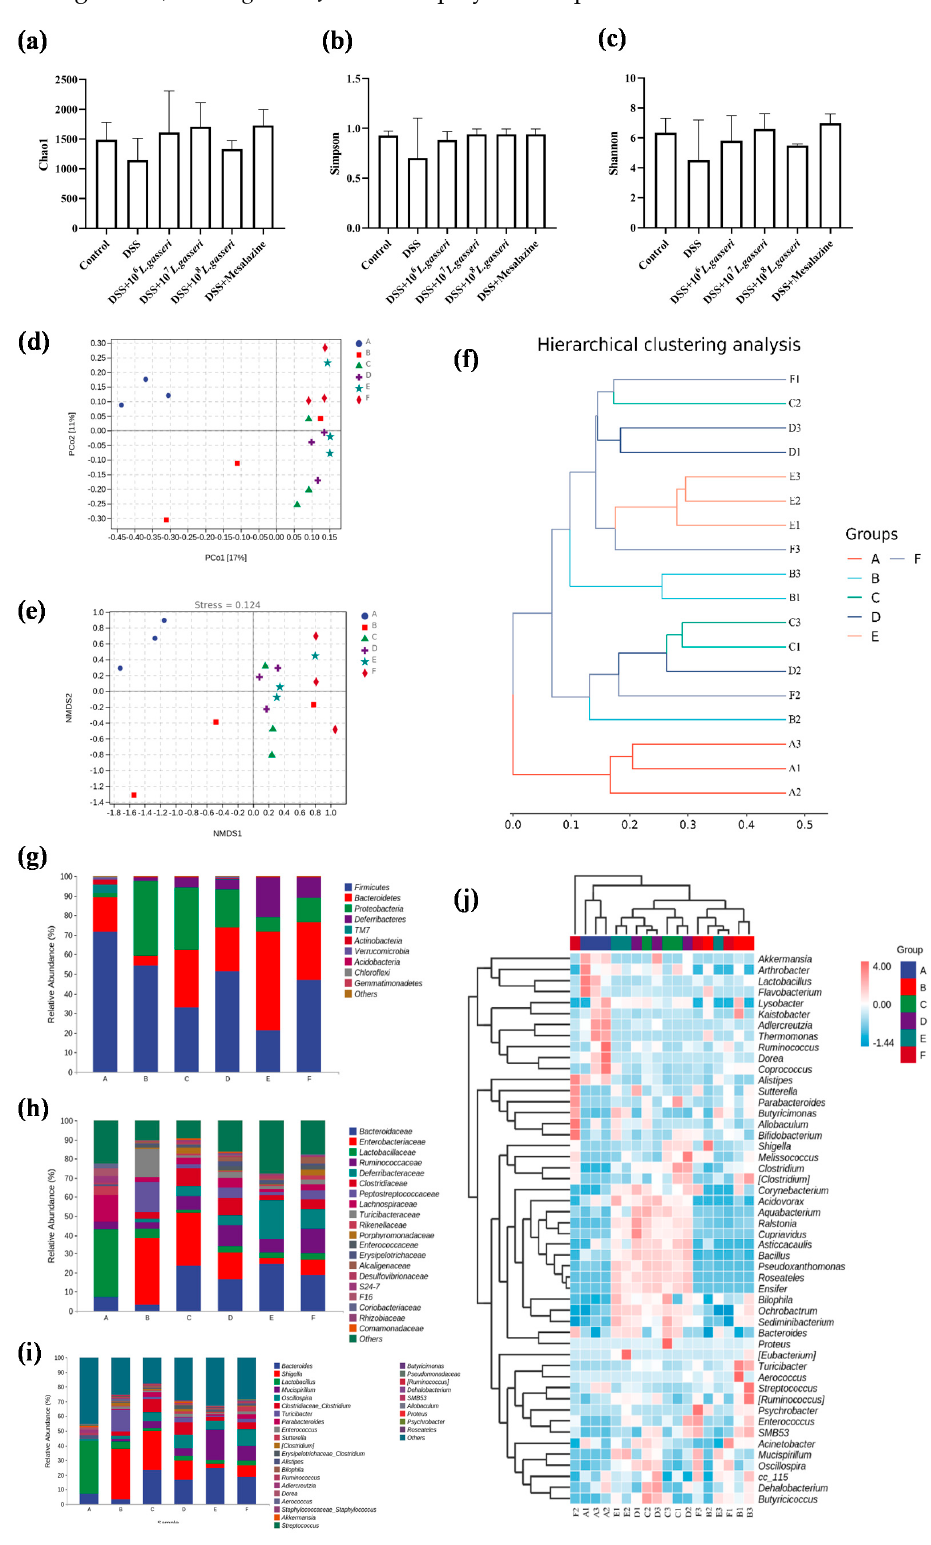
Figure 8. Differences in intestinal microbiota composition among the six groups ( n = 3). ( a ) Chao1 index, ( b ) Simpson Index, ( c ) Shannon Index, ( d ) PCoA analysis of groups, ( e ) NMDS analysis of groups, ( f ) UPGMA hierarchical clustering analysis of microbiology in groups, ( g ) microbial